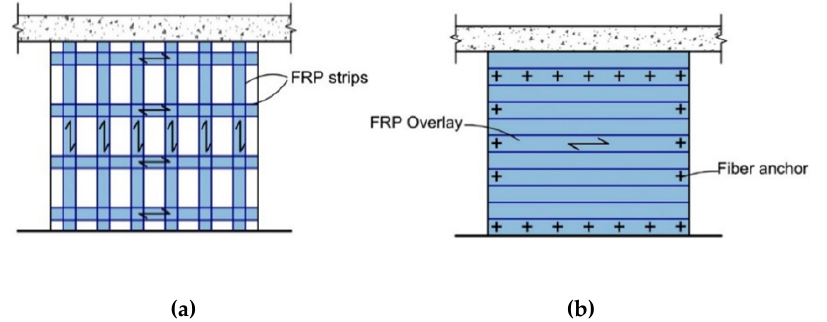
Figure 7. Seismic retrofitting of masonry walls using FRPs: ( a ) a FRP overlay applied over the entire wall surface, and ( b ) horizontal and vertical FRP strips [30].